Question: What type of chart is this?
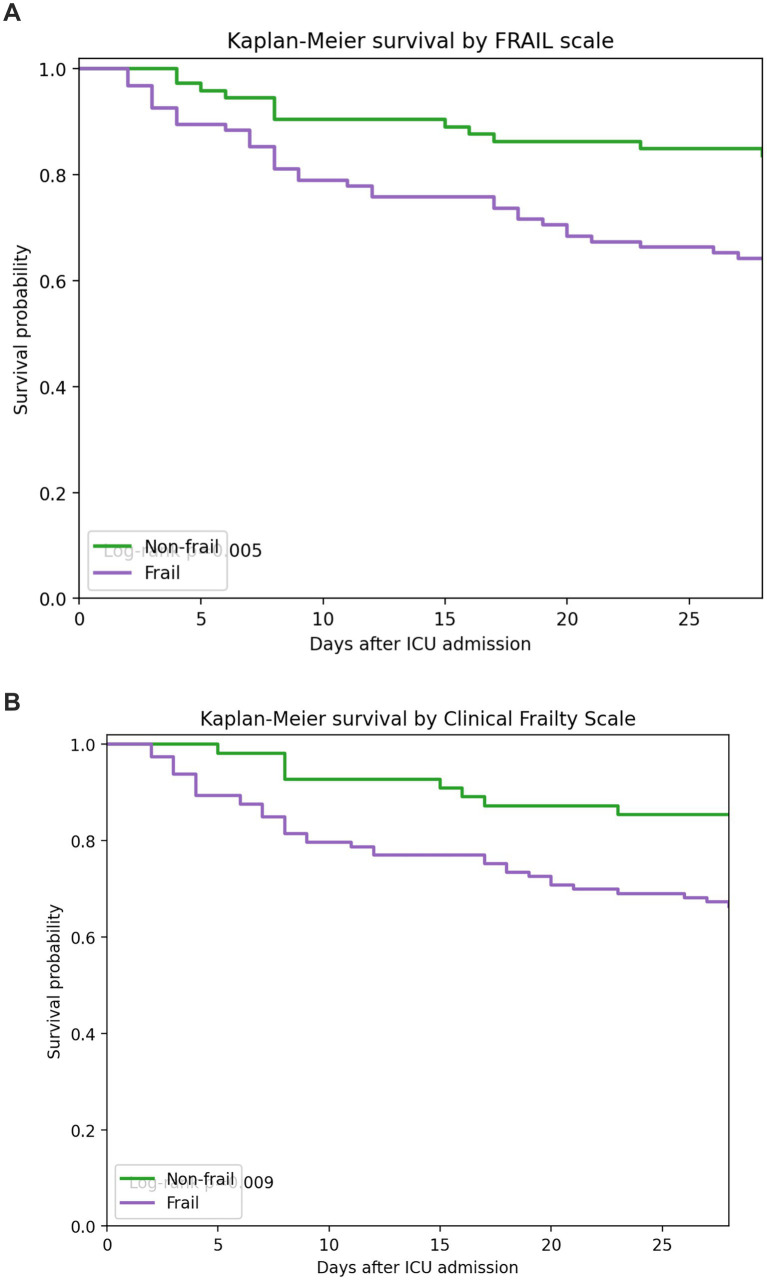
Answer: survival